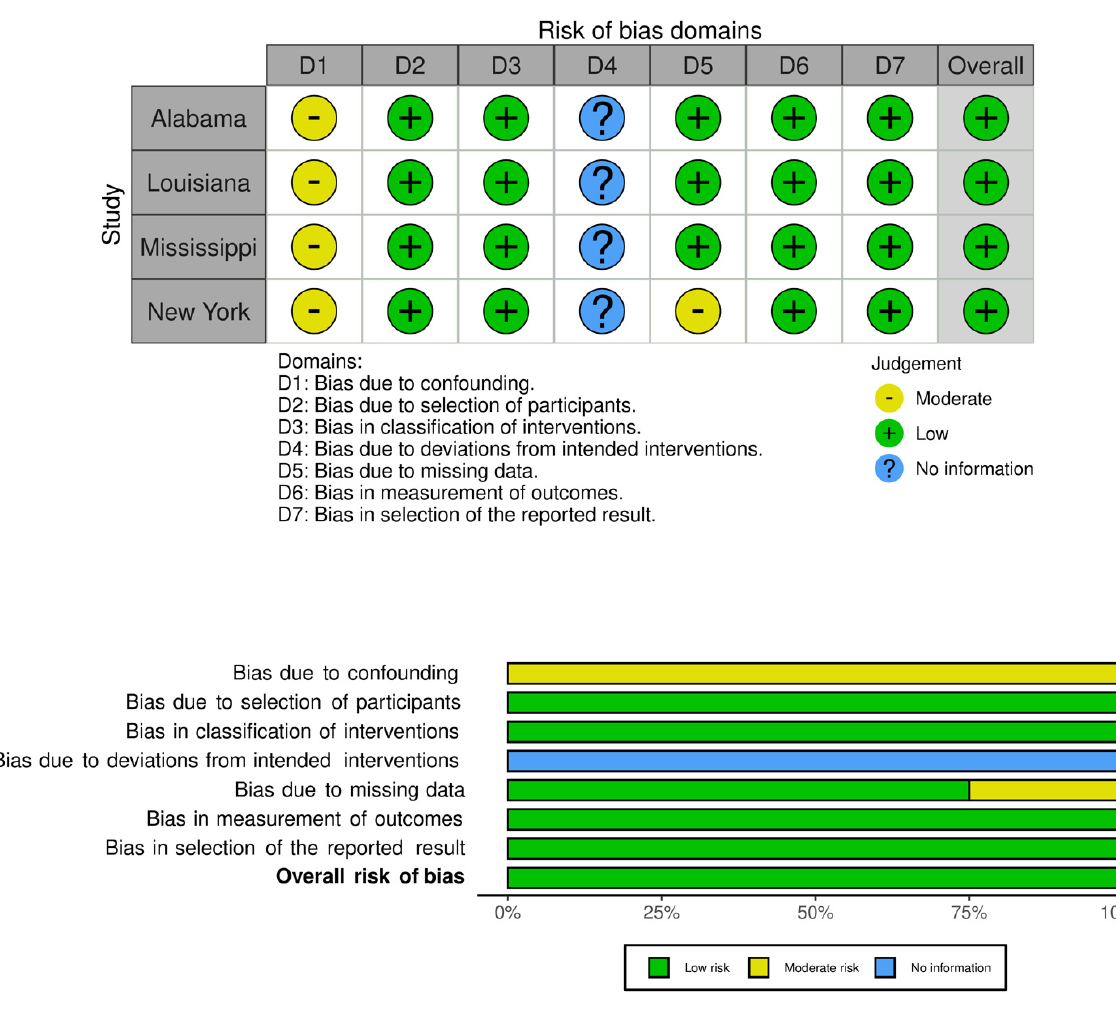
Figure 4. Assessment of the risk of bias using ROBINS-1. Shown are the traffic light plot ( above ) and the summary plot ( below ). We used comorbidity as an intervention and death as an outcome. No information (Blue) is not applicable to this study. We used a visualization tool as described in [17].